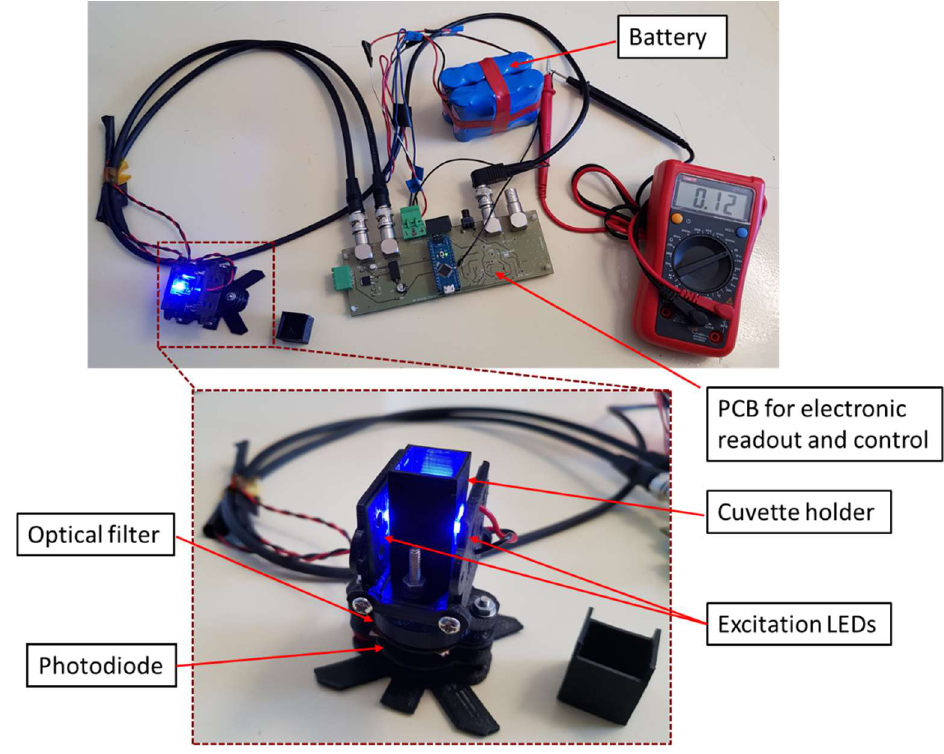
Figure 11. Photograph of the developed device showing the several subsystems.